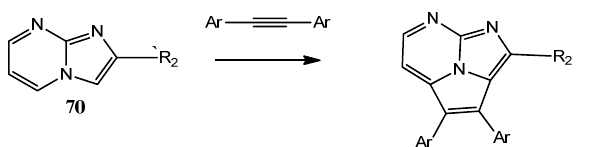
Separate catalyzed reaction of imidazopyrimidines 70 with diaryl acetylenes gave library of compounds with anti-inflammatory activity [11], Scheme 35, Table 17. brary of compounds with anti-inflammatory activity [11], Scheme 35, Table 17.